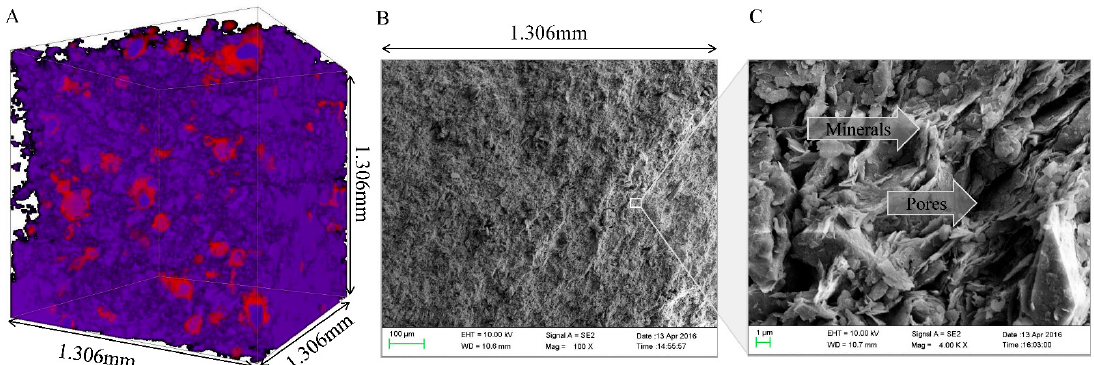
Figure 5. Minerals combined with pores. ( A ) Three-dimensional data-constrained modelling (DCM) model of clay mineral bound with pores (red denotes minerals, and purple indicates a mix of minerals and pores; ( B ) Amplified SEM image at 100 times magnification; ( C ) Amplified SEM image at 4000 times magnification).